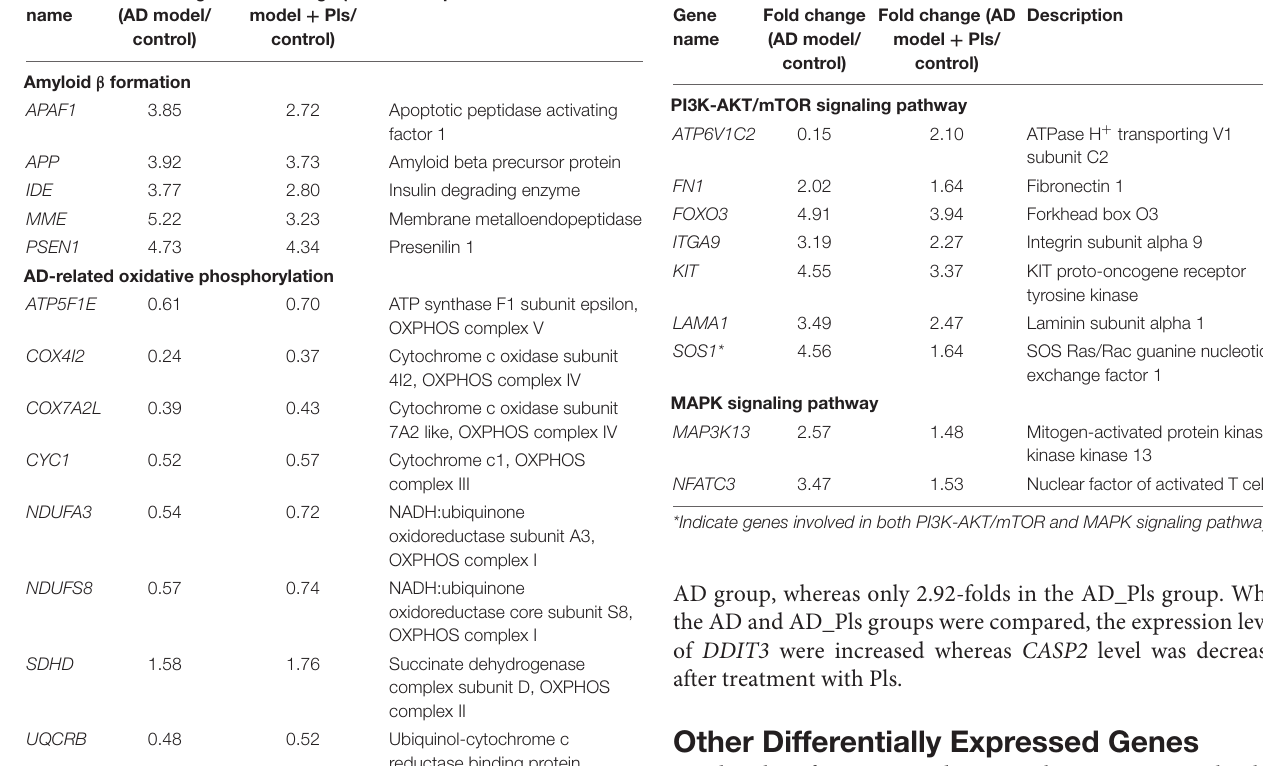
TABLE 3 | List of the significant ( p < 0.05) PI3K-AKT/mTOR and MAPK signaling pathways related DEGs and respective fold changes identified among different